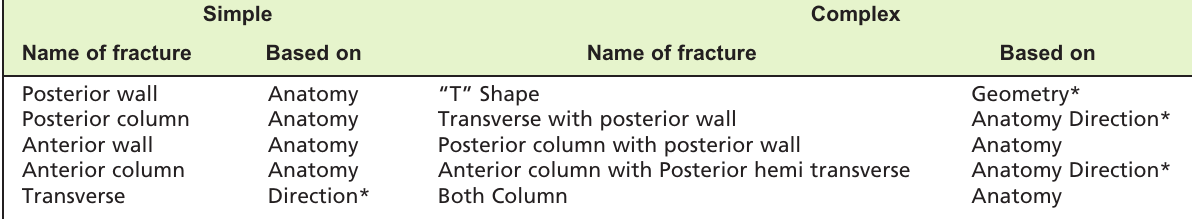
Classification of acetabulum fractures as proposed by Judet and Letournel Table I: